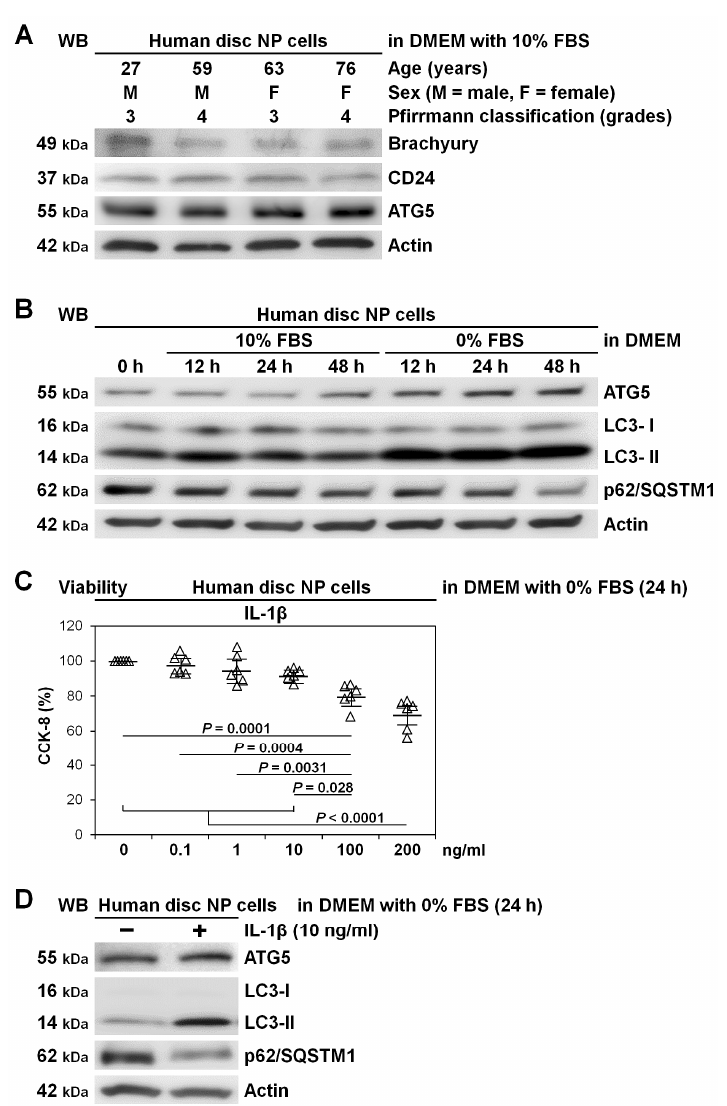
Figure 2. Basal and serum deprivation and inflammation-induced autophagy in human disc nucleus pulposus (NP) cells. ( A ) Western blotting for disc NP-phenotypic brachyury and CD24 and autophagic ATG5 in total protein extracts from human disc NP cells of patients who underwent lumbar spine surgery for degenerative disease after culturing for 240 h in Dulbecco’s modified Eagle’s medium (DMEM) with 10% FBS. Actin was used as a loading control. Immunoblots show samples randomly selected ( n = 4). ( B ) Time-course Western blotting for autophagic ATG5, LC3, and p62/SQSTM1 and loading control actin in total protein extracts from human disc NP cells after up to 48 h culture in serum-supplemented DMEM with 10% FBS or serum-free DMEM with 0% FBS. Immunoblots shown are representative of experiments with similar results ( n = 6). ( C ) Cell viability of human disc NP cells using CCK-8 after 24 h treatment of 0–200 ng/mL IL-1 β in serum-free DMEM with 0% FBS. Changes in CCK-8 dehydrogenase activity of IL-1 β treatment relative to the vehicle control are shown. Data are the mean ± 95% CI. One-way repeated-measures ANOVA and the Tukey–Kramer post-hoc test were used ( n = 6). ( D ) Western blotting for autophagic ATG5, LC3, and p62/SQSTM1 and loading control actin in total protein extracts from human disc NP cells after 24 h culture in serum-free DMEM with or without 10 ng/mL IL-1 β . Immunoblots shown are representative of experiments with similar results ( n = 6).